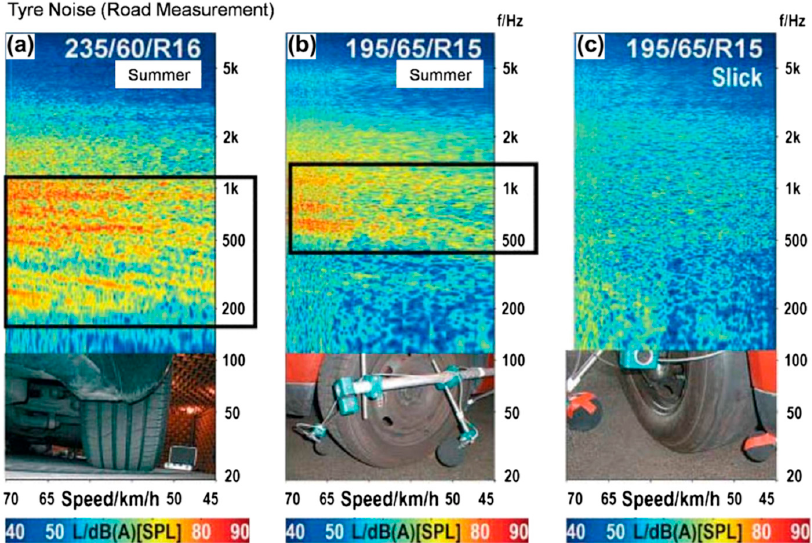
Figure 18. Waterfall plots of tire/road noise measured on the road with three different tire types: ( a ) wide summer tire; ( b ) regular summer tire; ( c ) slick tire (source from Braun et al., 2013 [155], Figure 20; original from Alt et al., 2006, [154]; reprinted with permission from Elsevier).